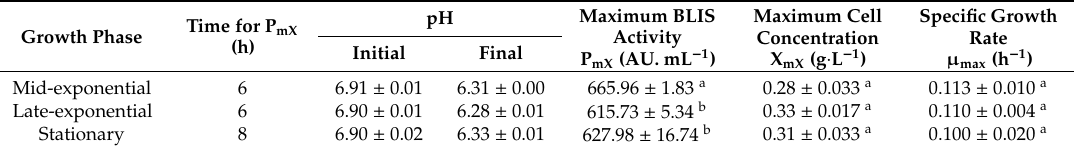
Table 3. Effects of initial culture pH on growth of L. lactis Gh1 and BLIS production using BHI medium. Table 4. Growth of L. lactis Gh1 and BLIS production using BHI medium, inoculated with di ff erent ages of inoculum. The inoculum age was set at 1% ( v / v